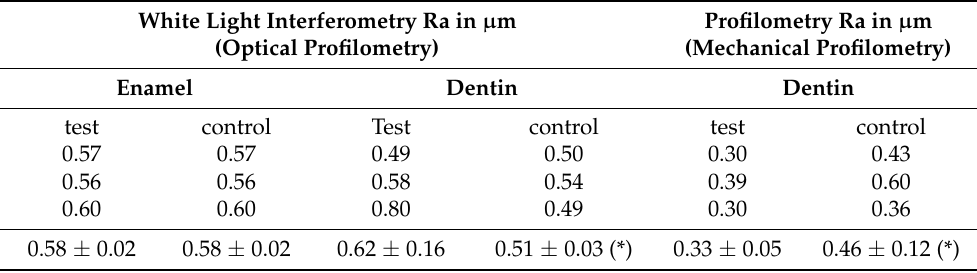
Table 2. Mean Ra values from three test and control samples obtained from optical and mechanical profilometry. Significant differences between the test and control groups are marked by